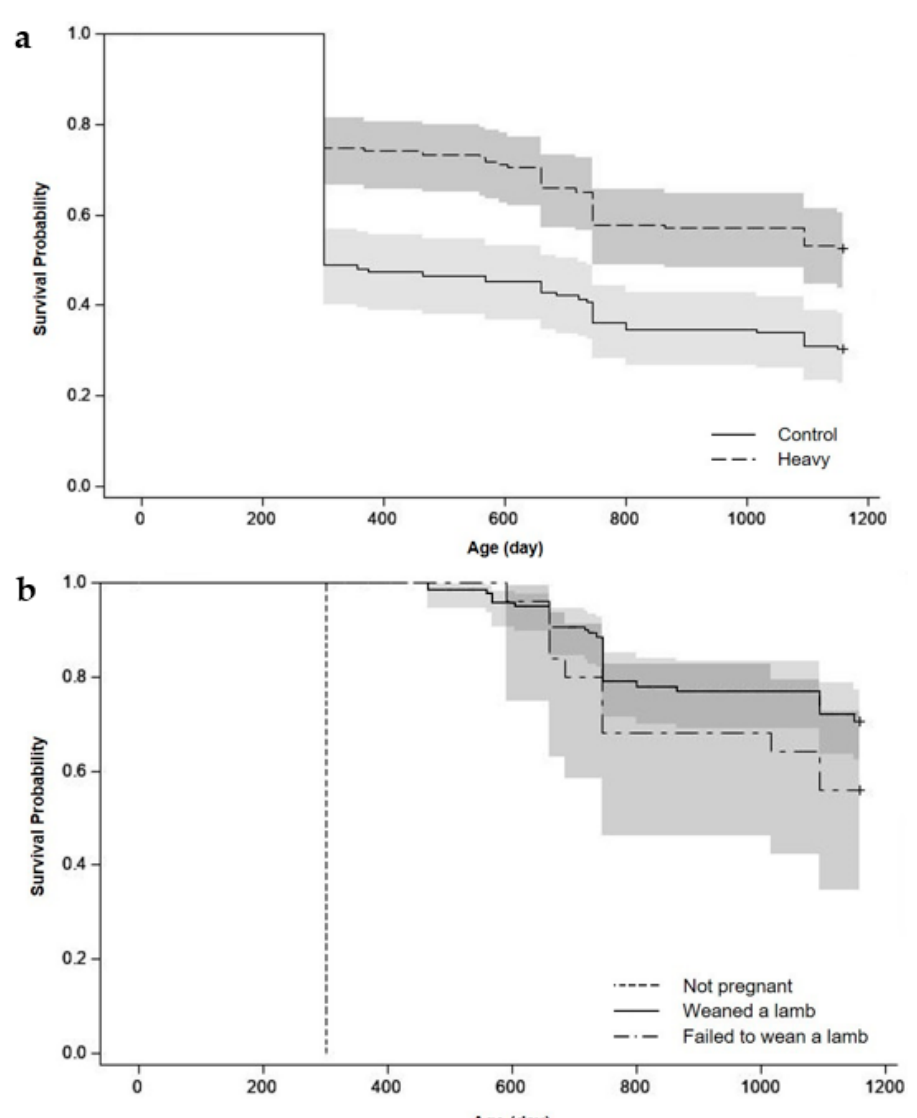
Figure 5. Predicted retention curves and 95% confidence interval (grey area) of ewes in the flock based on ( a ) treatments (control or heavy) and ( b ) ewe lamb status (not pregnant or weaned a lamb or failed to wean a lamb) for the three-year period of the experiment at 1159 days of age with the hypothetical culling policy: ewe lambs that were not pregnant were culled at pregnancy diagnosis (d301) and ewe lambs whose lambs died were not culled, and at two and three years of age, non- pregnant ewes at pregnancy diagnosis (d660 and d995) and ewes whose lambs died before weaning (d800 and d1159) were culled.